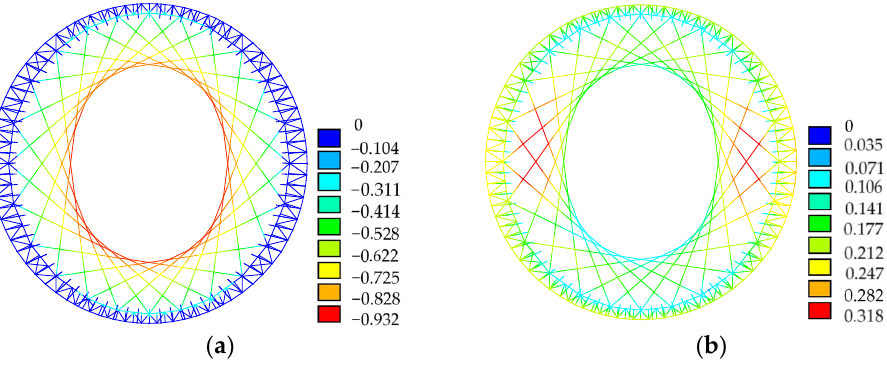
Figure 4. Contours of envelope displacements: ( a ) vertical downward displacements/m and ( b ) ver- tical uplift displacements/m.